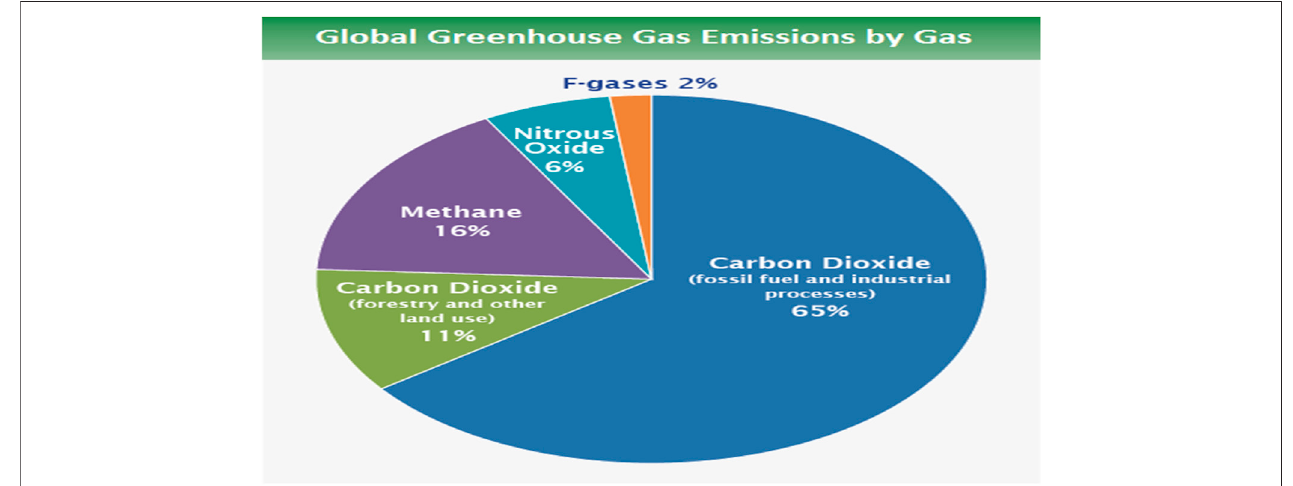
FIGURE 4 | Global greenhouse gas emissions by gas (Boden et al.,